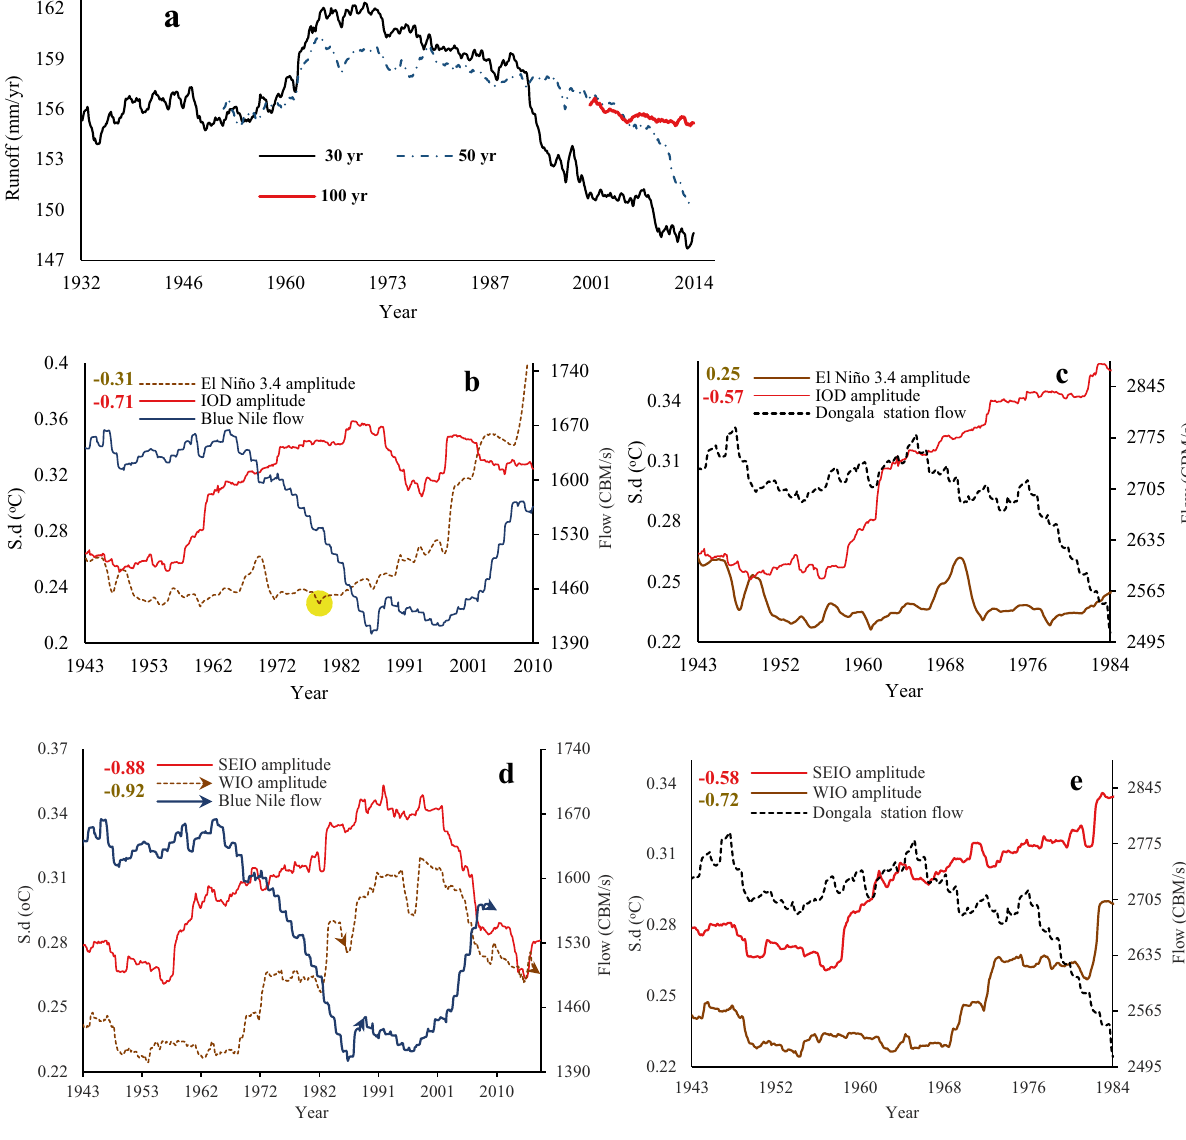
Figure 10. Teleconnections between NRB’s flow variability, ENSO and IOD. ( a ) 30-, 50- and 100-year moving average of annual runoff over the Nile River basin ( a ). Responses of NRB flow variability to El Niño events, IOD amplitude and the IOD two pole amplitudes i.e., western pole amplitude (WIO) and eastern pole amplitude (SEIO) based on the detrended cross correlation between NRB flow at Blue Nile and Dongala stations and El Niño 3.4, IOD amplitudes ( b , c ), SEIO, and WIO amplitudes ( d , e ), respectively. The NRB flow are computed over 30-year running periods from 1913 to 2012 for the Blue Nile station, and from 1913 to 1984 for Dongala station. El Niño 3.4, IOD, SEIO, WIO amplitudes are computed as the s.d. of the El Niño 3.4, IOD, SEIO, WIO over 30-year windows from 1913 to 2017, using the ERSST data